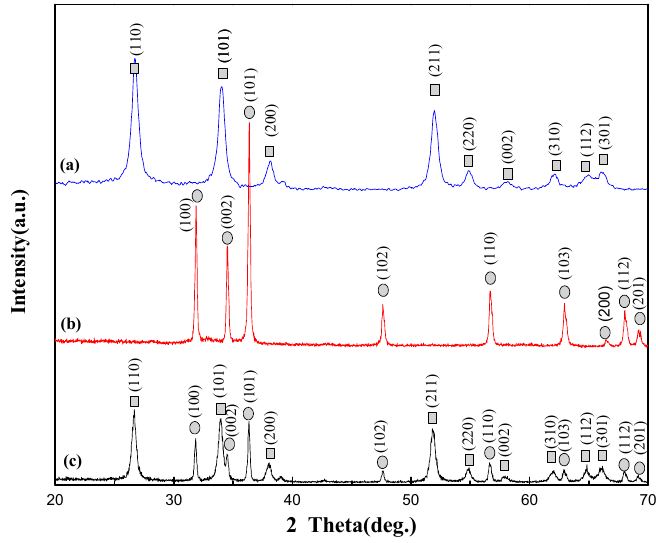
Figure 1. XRD patterns of ( a ) SnO 2 nanofibers, ( b ) ZnO nanorods, and ( c ) SnO 2 /ZnO nanofibers.